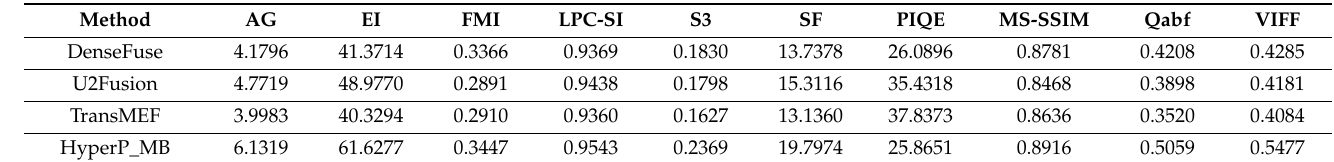
Table 1. Comparison of image-quality metrics score with existing image fusion methods: HyperP_MB denotes a deep learning model that applies our training